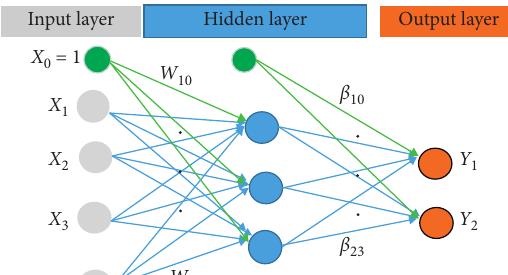
Figure 1: Multilayer neural network with one hidden layer: MLP 4-1-2.